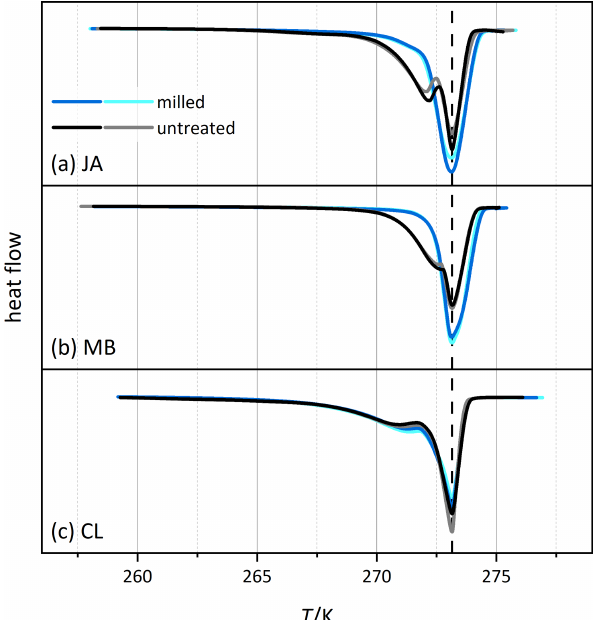
Figure 6. Thermograms from melting experiments of slurries of se- lected halloysite samples (black/gray) and the corresponding mea- surements of the milled samples (blue/cyan). The curves are nor- malized with respect to their total integral. Dust sample codes are identical to those in Fig. 2.